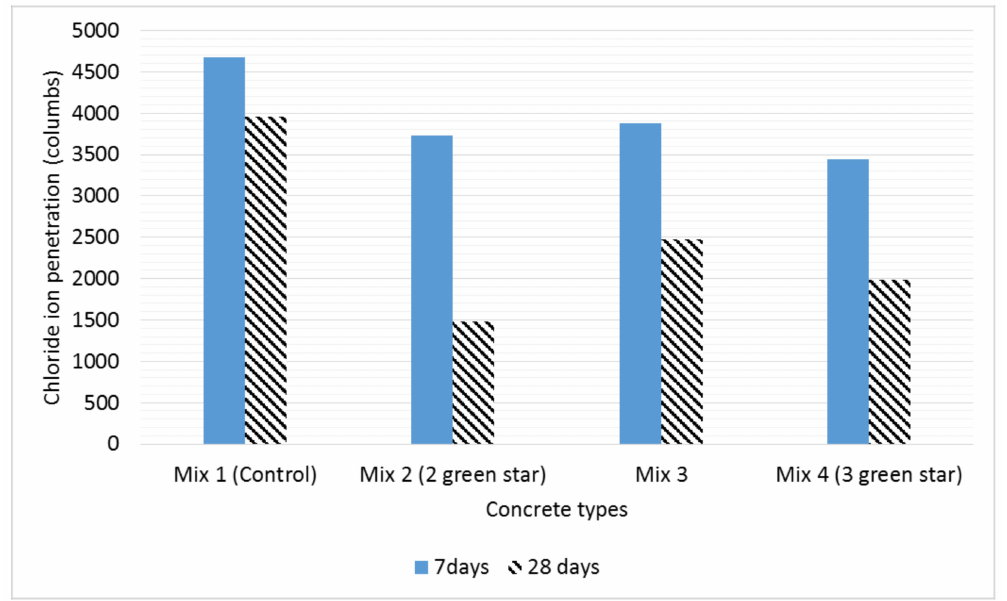
Figure 10. Measured chloride ion prenetration of green star concretes and control